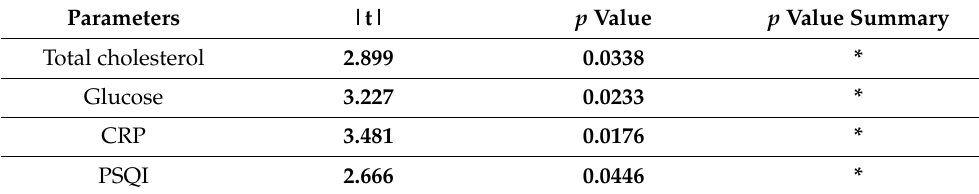
Table 5. Variables independently associated with the RLS diagnosis in psoriatic patients.